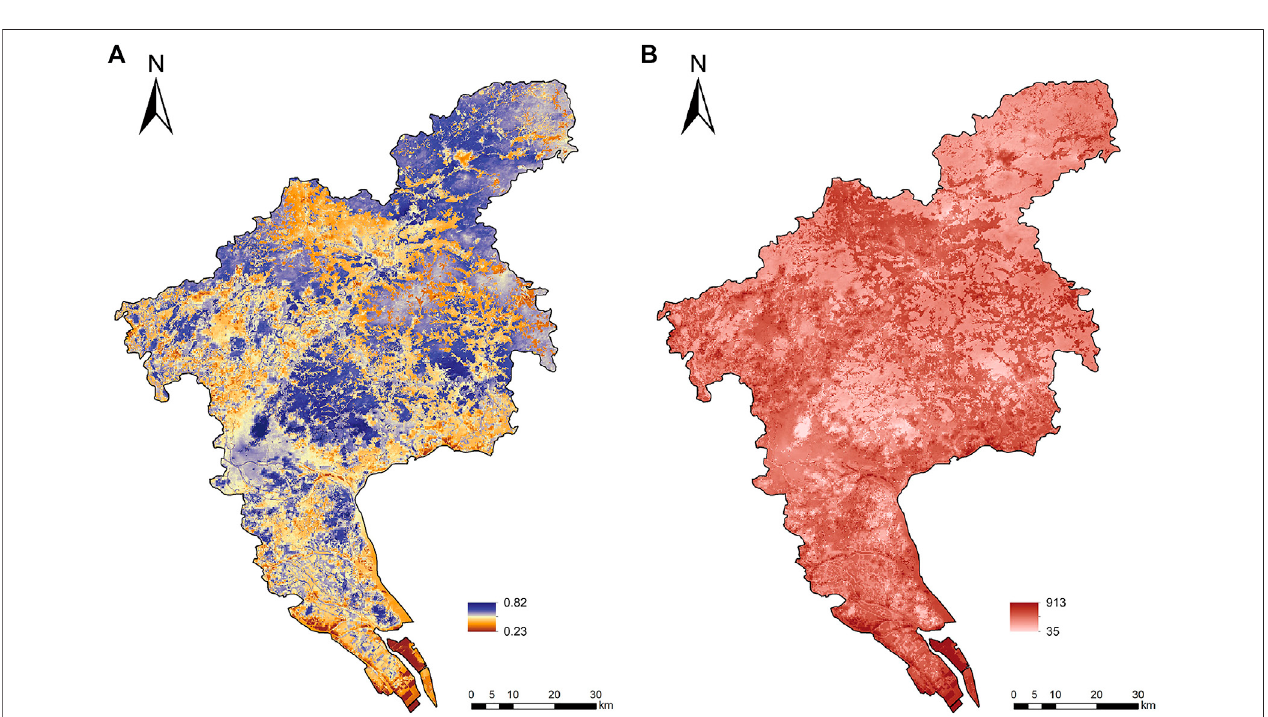
FIGURE 6 | (A) is comprehensive evaluation, (B) is resistance surface.